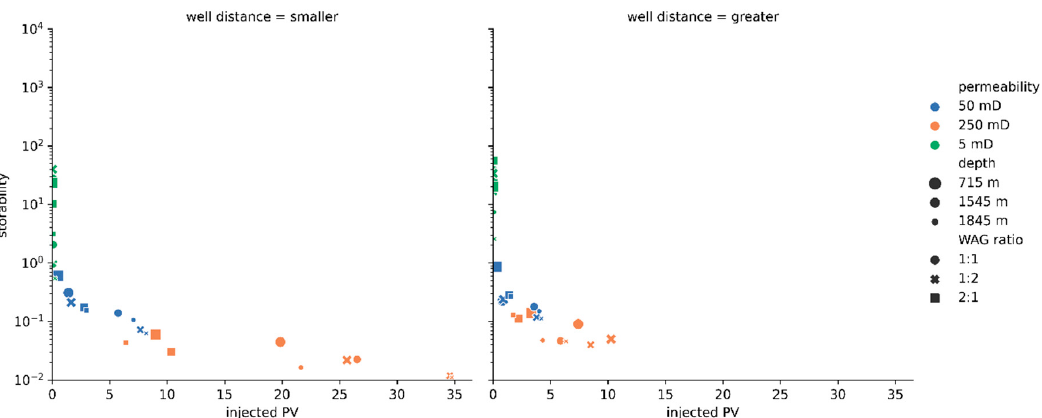
Figure 8. Storability versus injected pore volumes after 15 years of EOR.